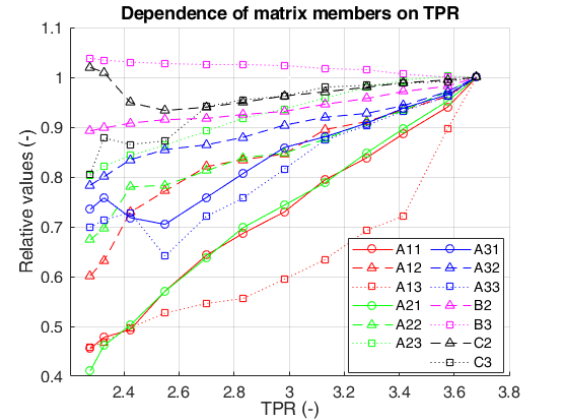
Figure 3. Dependence of matrix members on